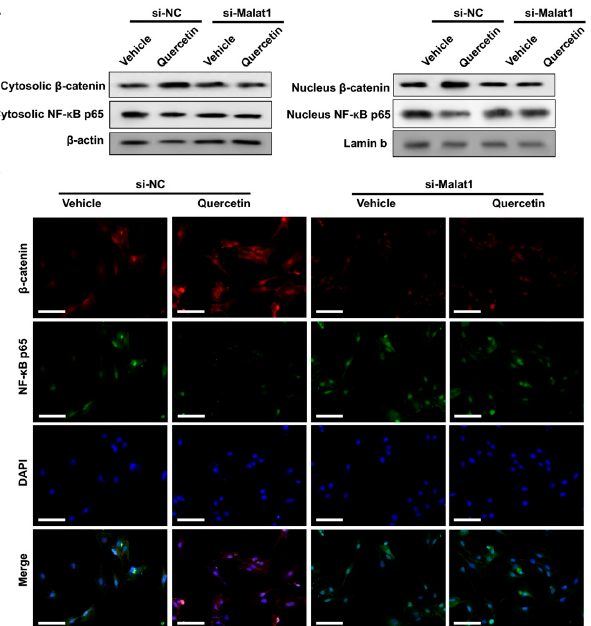
Figure 6. Effect of quercetin on promoting Wnt/ β -catenin and repressing NF- κ B signaling was ameliorated by Malat1 knockdown. The BMSCs were Malat1 knockdown, pre-conditioned with TNF α for 12 h and treated with quercetin for 3 days. ( A ) Western blot analysis of NF- κ B p65 and β -catenin nucleus translocation of the BMSCs upon TNF α pre-treatment and quercetin administration. ( B ) Immunofluorescence (IF) staining analysis of the β -catenin and NF- κ B p65 nucleus translocation of the BMSCs upon TNF α pre-treatment and quercetin administration. DAPI was included as an internal control. Scale bar: 100 µ M.